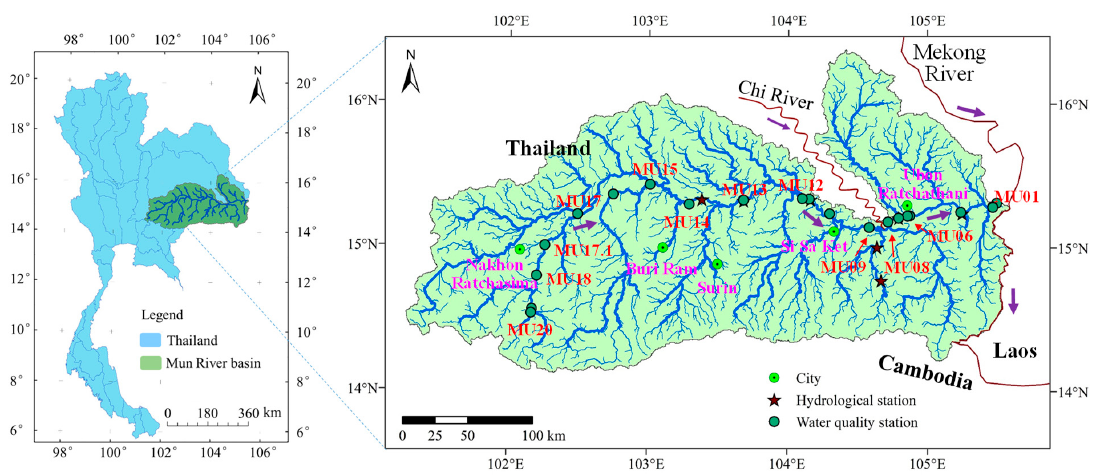
Figure 1. The location of the Mun River basin and the water quality monitoring sites along the river.